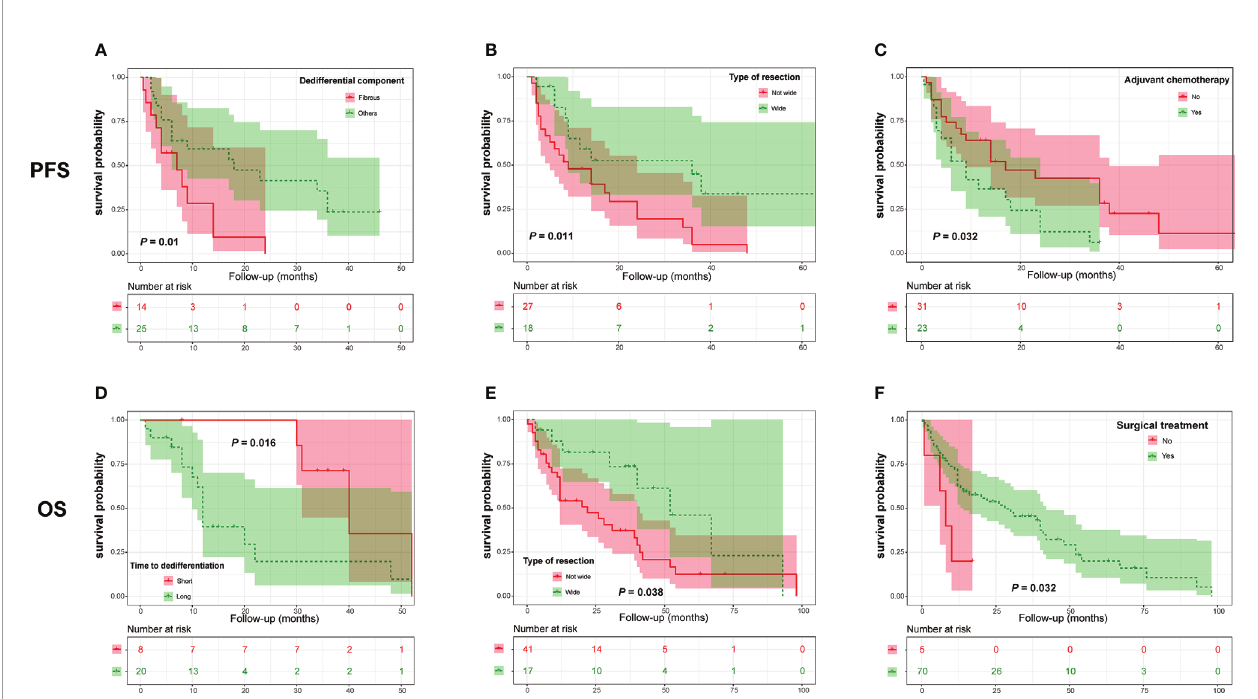
FIGURE 4 | Kaplan-Meier curves of progression-free survival of patients with dedifferentiated chordoma strati fi ed by dedifferentiation component (A) , resection type (B) and adjuvant chemotherapy (C) , as well as overall survival of patients strati fi ed by time to tumor dedifferentiation (D) , type of resection (E) and surgery (F)